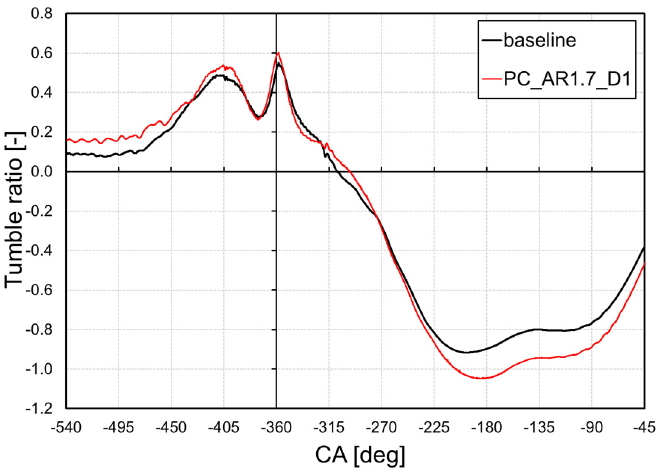
Figure 9. Comparison between simulated tumble ratio trends during exhaust, intake, and compres- sion phases.